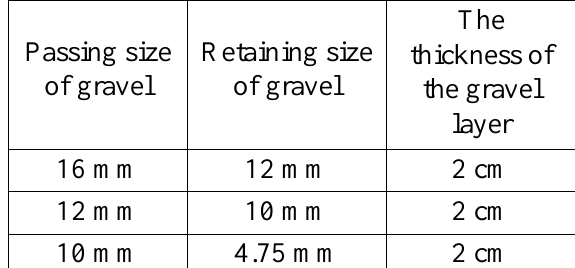
Table 1. Details of the gravel layer Passing size of gravel